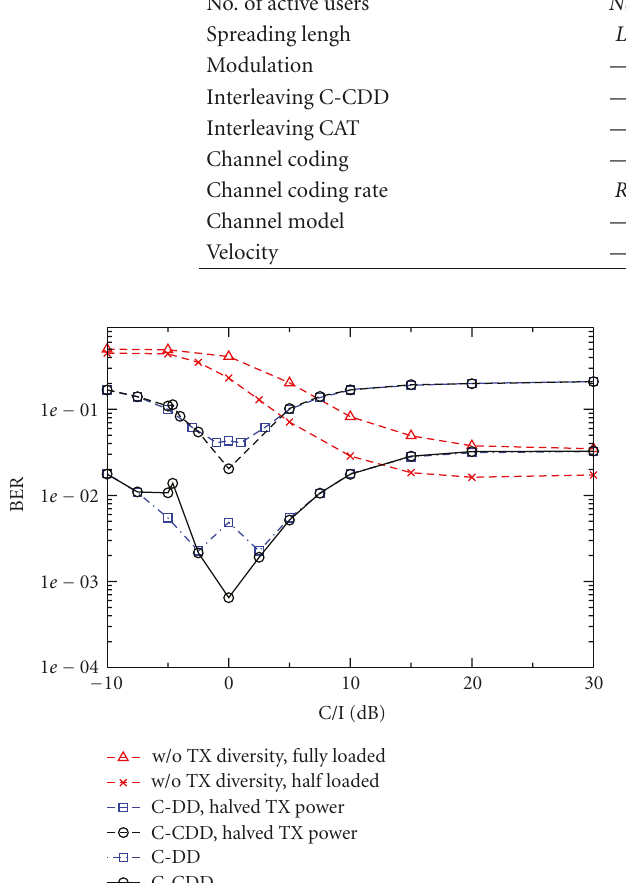
Figure 10: BER versus C/I for an SNR of 5dB using no transmit diversity technique, C-DD, and C-CDD for di ff erent